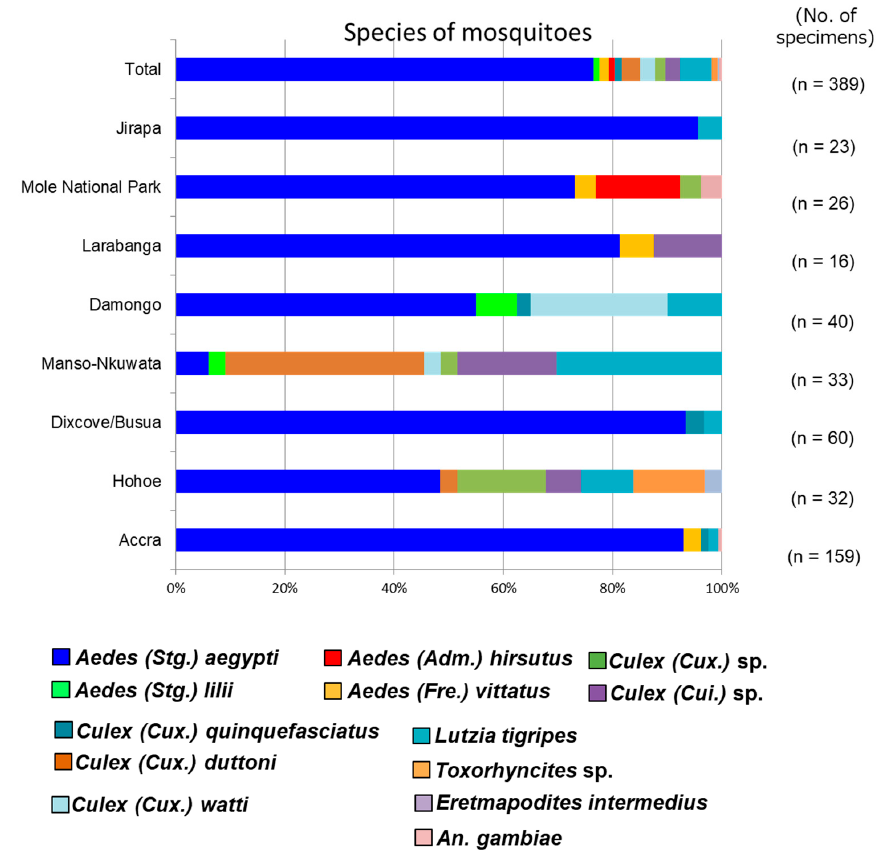
Figure 2. Relative abundance of mosquito species in the collection sites. A total of 13 different species of mosquitoes were detected across 6 regions. Aedes (Stg.) aegypti was the most widely distributed mosquito species across the collection sites. Aedes (Stg.) lilii and Aedes (Adm.) hirsutus were detected for the first time in Ghana.